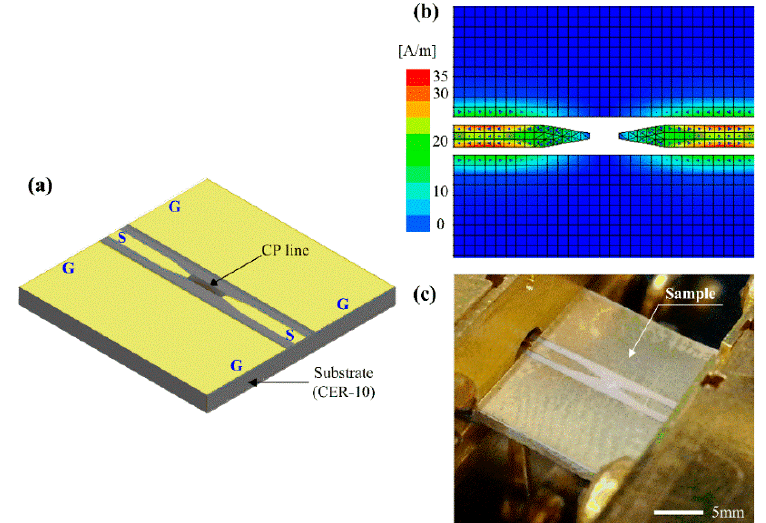
Figure 1. Design, simulation, and fabrication of a bare coplanar waveguide (CPW) device; ( a ) Schematic of the CPW device with a PEDOT:PSS line. The overall area of the CPW device is 10 mm × 10 mm; ( b ) Average surface current distribution at 2 GHz; ( c ) Sample image of the bare CPW device.